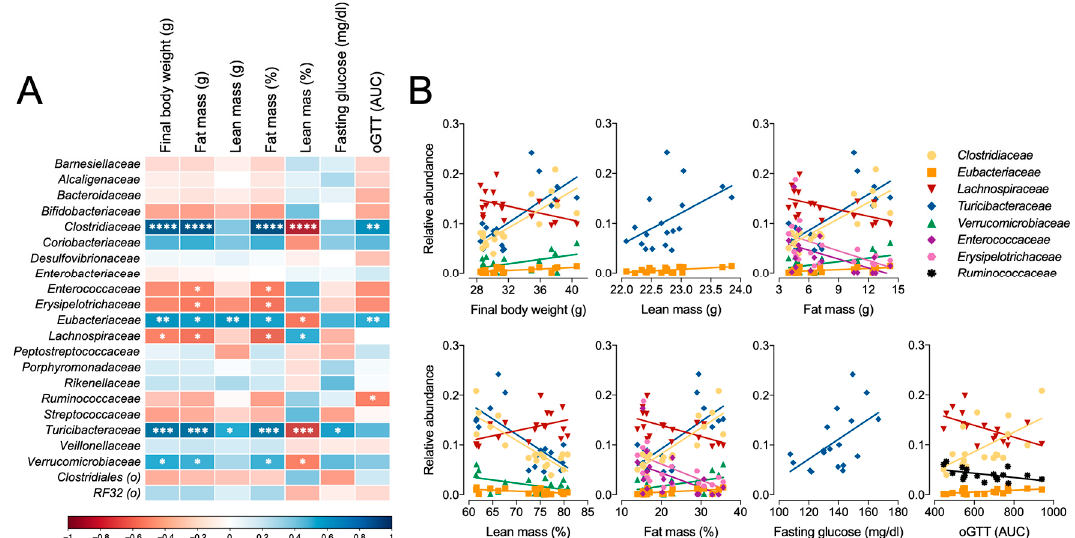
Figure 8. ( A ) Correlation analysis for major bacteria families with key phenotype endpoints. ( B ) Linear regressions are shown for bacteria significantly correlated for each endpoint. The scale indicates Pearson r correlation value and direction. Pearson correlation significance indicated by * p < 0.05, ** p < 0.01, *** p < 0.001, **** p < 0.0001.